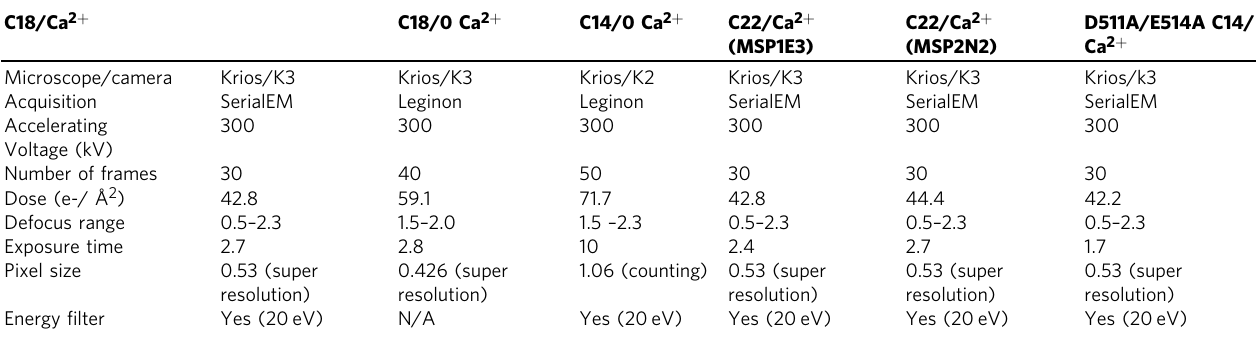
Table 2 Electron microscopy data collection